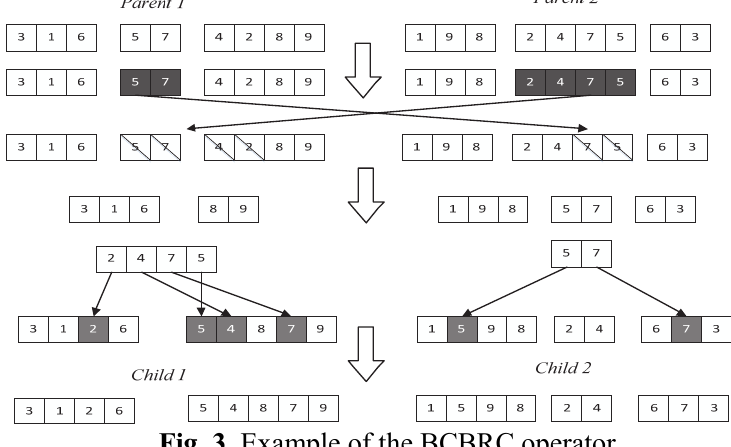
Fig. 3 . Example of the BCBRC